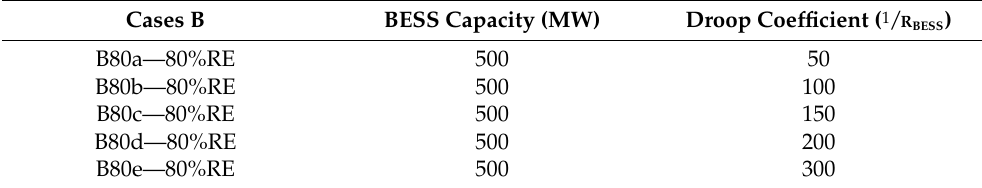
Table 5. Group B, different droop coefficient, fixed BESS capacity, A80—80% RE penetration. Cases B